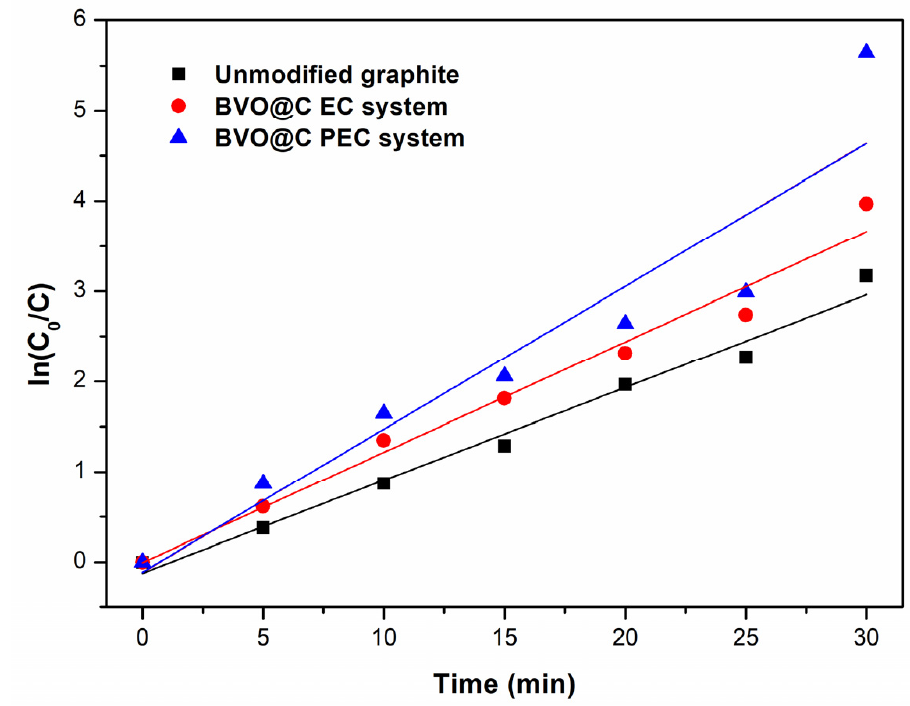
Figure 10. Kinetic plots of apparent first-order linear transform ln (C 0 /C) against time of irradiation (t) with unmodified graphite and BVO@C.